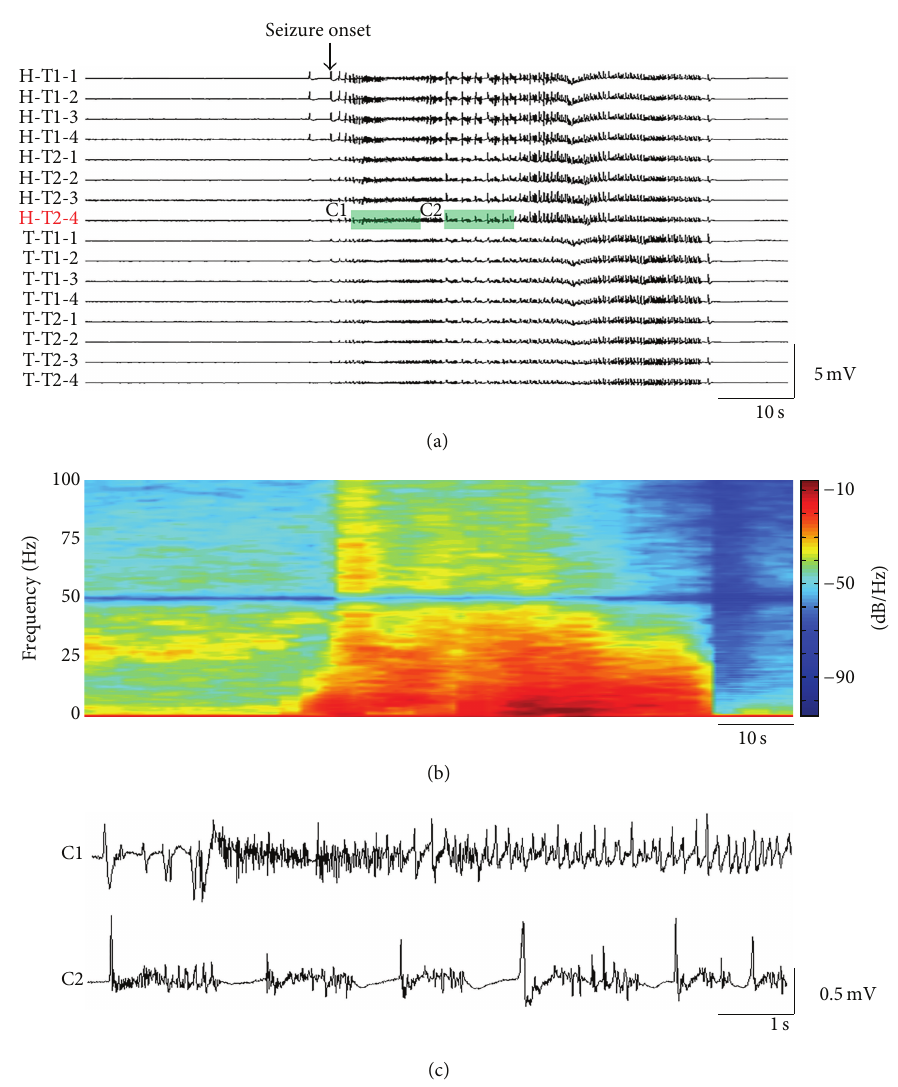
Figure 2: LFPs during the first seizure of an example mouse. (a) Single seizure recorded by four tetrodes. All data were filtered at 0.5–100 Hz. The seizure onset time is marked by an arrow. (b) Power spectral of LFP from Channel H-T2-4. (c) The details of the recordings shown in the shadow in (a). (C1) shows the tonic phase of epileptic seizure and (C2) shows the clonic phase of epileptic seizure. H, hippocampus; T, thalamus; T1&T2, Tetrode 1 and Tetrode 2 in a